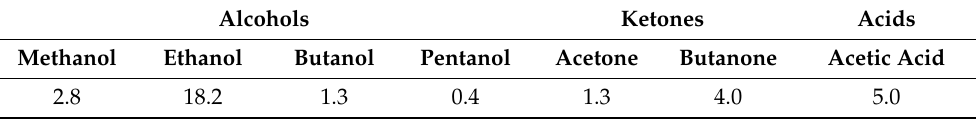
Table 4. Composition of Fischer–Tropsch synthesis products dissolved in water, rel. %.